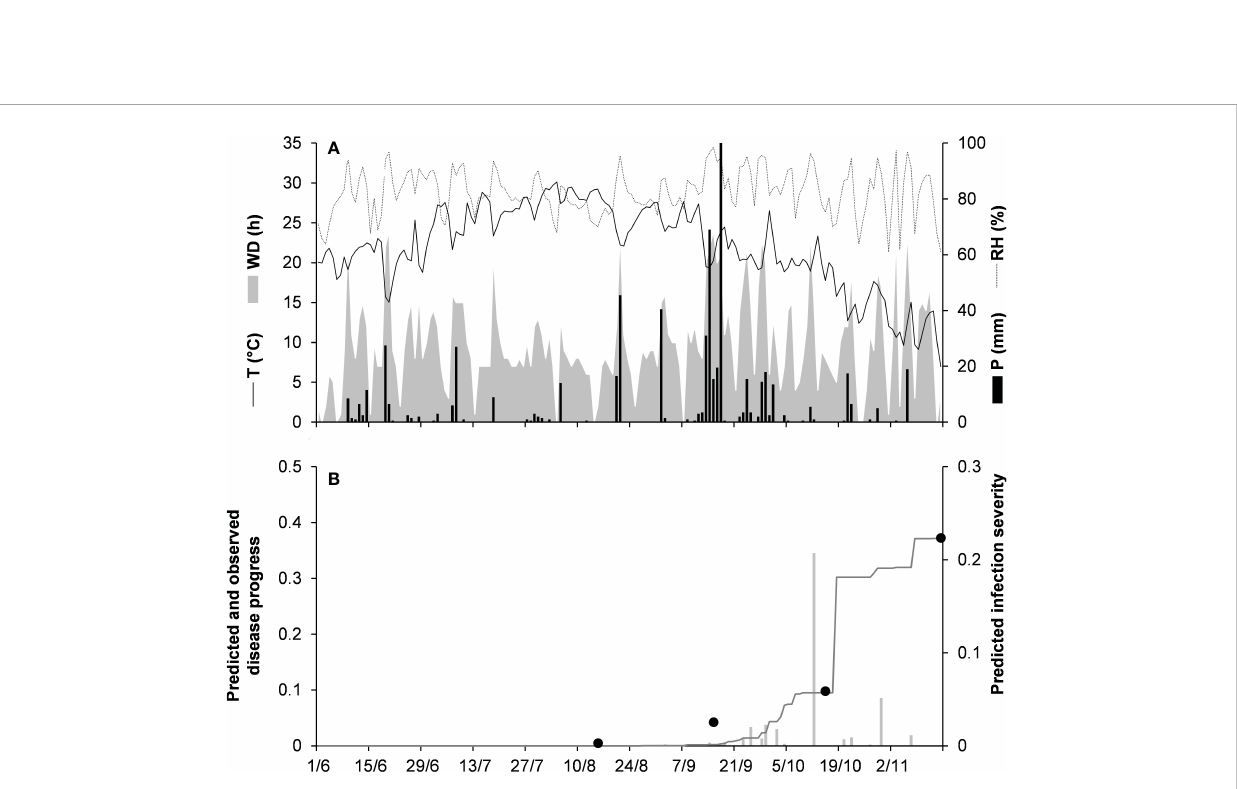
FIGURE 4 Predicted and observed disease progress on mulberry for the dematium clade in Tsukuba, Ibaraki, Japan, in 1994 (JA-94). (A) Weather variables: air temperature (T, °C, solid line), relative humidity (RH, %, dotted line), rainfall (P, mm, black bars), and wetness duration (WD, in h, gray area). (B) Infection severity predicted by the model (light gray bars), disease severity predicted by the model (dark gray line), and observed disease incidence (full